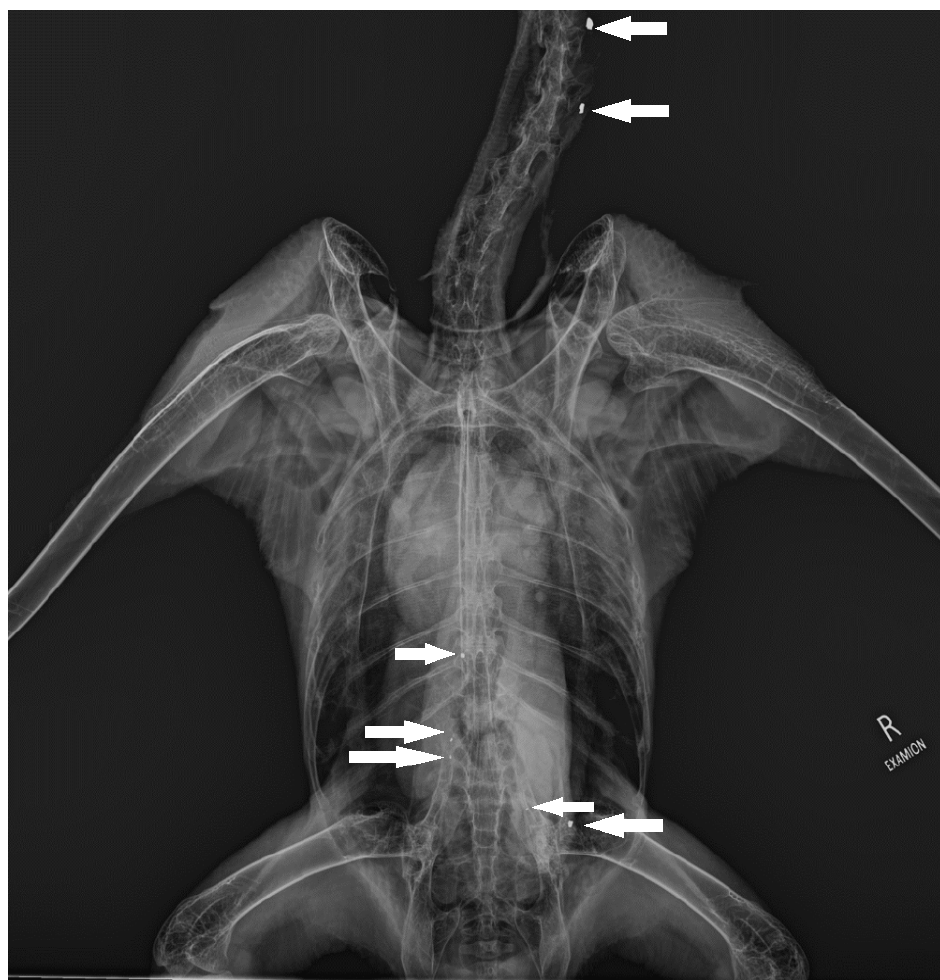
Figure 2. The ventrodorsal radiograph of adult White-Tailed Sea Eagle ( Haliaeetus albicilla ) (number 5). Arrow showing small metallic opacities suggestive for ingested Pb ammunition particles in different segments of gastrointestinal tract.